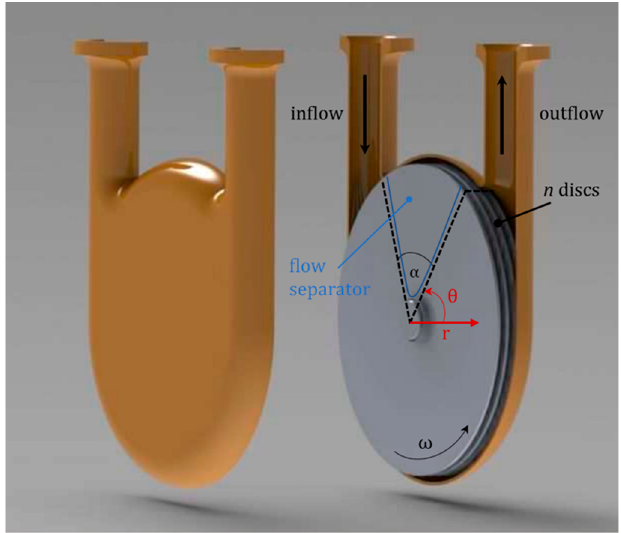
Figure 1. Geometric concept of bladeless heart pump.